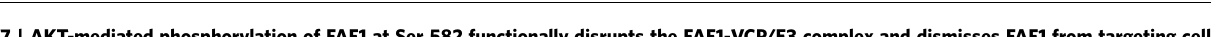
Figure 7 | AKT-mediated phosphorylation of FAF1 at Ser 582 functionally disrupts the FAF1-VCP/E3 complex and dismisses FAF1 from targeting cell surface T b RII. ( a , b ) Immunoblot (IB) of total cell lysate (TCL) and immunoprecipitants derived from HEK293T cells transfected with Flag-FAF1 and Myr-HA-AKT ( a ) or Flag-FAF1 wt/S582A/S582D expression plasmids ( b ) as indicated. *Indicates a non-specific band. ( c ) IB of TCL and immunoprecipitants derived from Myc-Ub stably expressed HEK293T cells transfected with T b RII-HA and Flag-FAF1 wt/SA/SD expression plasmids as indicated. ( d ) IB of TCL and biotinylated cell surface T b RII in MDA-MB-231 cells infected with Flag-FAF1 wt/S582A/S582D as indicated. ( e ) IB of TCL and immunoprecipitants derived from Myc-Ub stably expressed HEK293T cells transfected with T b RII and shFAF1 plasmids and treated with or without LY 294002 (LY, 50 m M for 6h) and TGF- b (5ngml (cid:2) 1 ) at the indicated time points. ( f ) IB of total T b RII in bone metastatic MDA-MB-231 cells treated with dimethylsulphoxide (DMSO) or N2, N4-dibenzylquinazoline-2,4-diamine (DBeQ; 10 m M) and LY294002 (50 m M) at the indicated time points. ( g ) IB of TCL and biotinylated cell surface T b RII in bone metastatic MDA-MB-231 cells infected with control (Co.sh) or shFAF1 lentivirus and treated with LY294002 (50 m M) at the indicated time points. ( h ) MDA-MB-231 cells expressing control vector (Co.vector) or DOX-inducible FAF1 wt/FAF S582A were injected intracardially into mice. DOX was administered 28 days after the inoculation of the cells (as indicated). Metastasis was measured by BLI. Normalized photon flux for the indicated time is presented; error bars, mean ± s.e. P values; Student’s t -test (left panel). Representative images (right panel). ( i ) In our working model, AKT phosphorylates FAF1 to disassociate the membrane FAF1–VCP/E3 complex, thereby stabilizing cell surface T b RII for oncogenic invasion or metastasis (in which AKT activation has already blunted cytostatic TGF- b /SMAD to support oncogenic